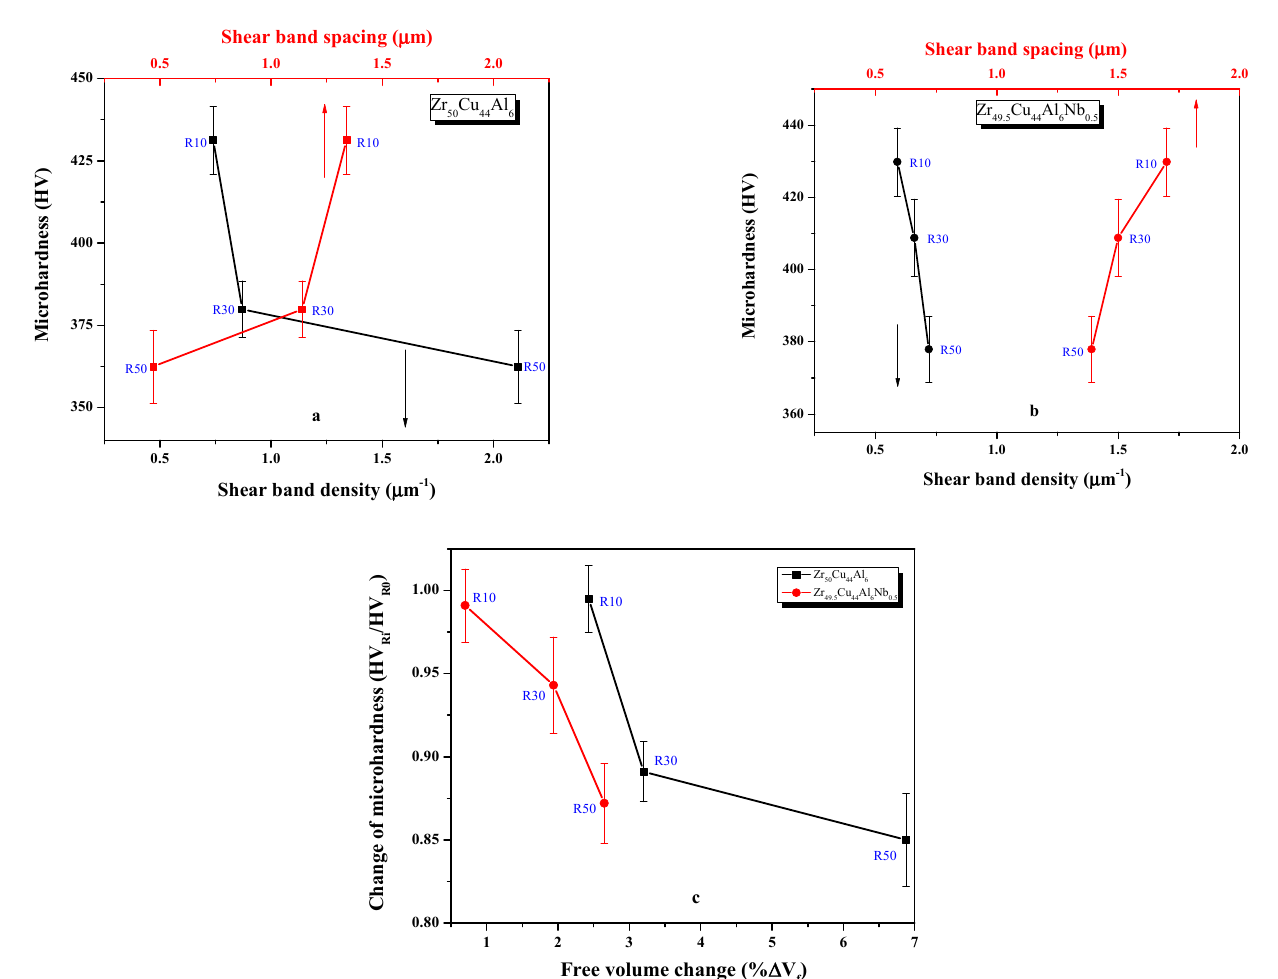
Figure 6. Changes in micro-hardness due to 1-D cold rolling plotted against mean shear band density/shear band spacing and free volume change as a function of 10%, 30%, and 50% plastic strain of ( a ) A1, ( b ) A2, and ( c ) A1 and A2 deformed ribbons.